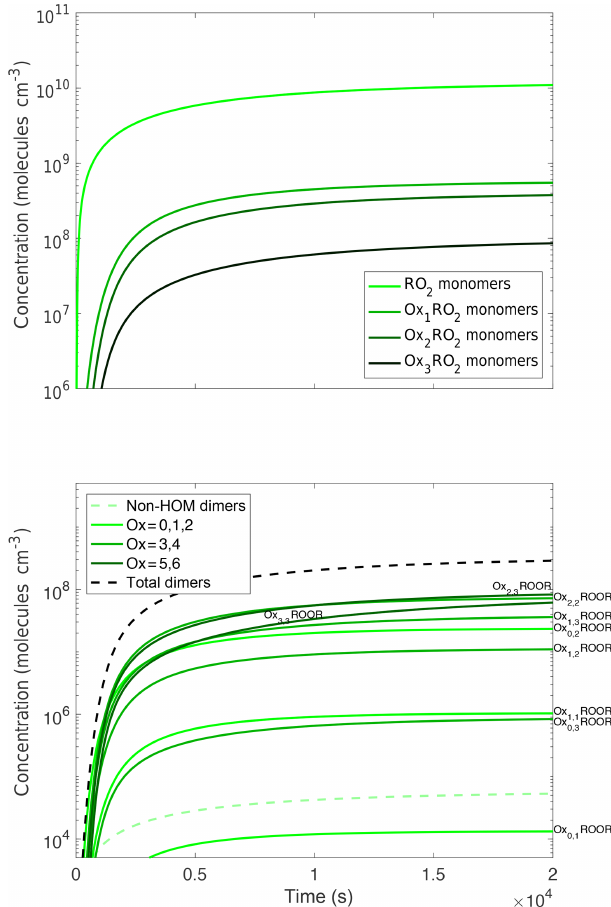
Figure 3. Concentration time series of monomer and dimer prod- ucts. Ox n indicates the number of autoxidation steps. All of these products are formed via peroxy radical chemistry, but the products are still predominantly non-HOM. This trend persists for hydroper- oxides and organonitrates when NO x is present. The dimers do not follow the same trend of forming more from the less oxidized per- oxy radical as the other species do. The dimer plot is colored by the sum of how oxidized the two peroxy radicals that reacted to form the dimer are (i.e., the dimerization of an Ox 1 RO 2 and an Ox 2 RO 2 would be considered the sum of Ox=3). However, they also do not follow the exact opposite trend. This is due to the branching ratio to dimers being larger for low-volatility peroxy radicals but those peroxy radicals being less common, leading to midrange oxidized peroxy radicals forming the most dimers.